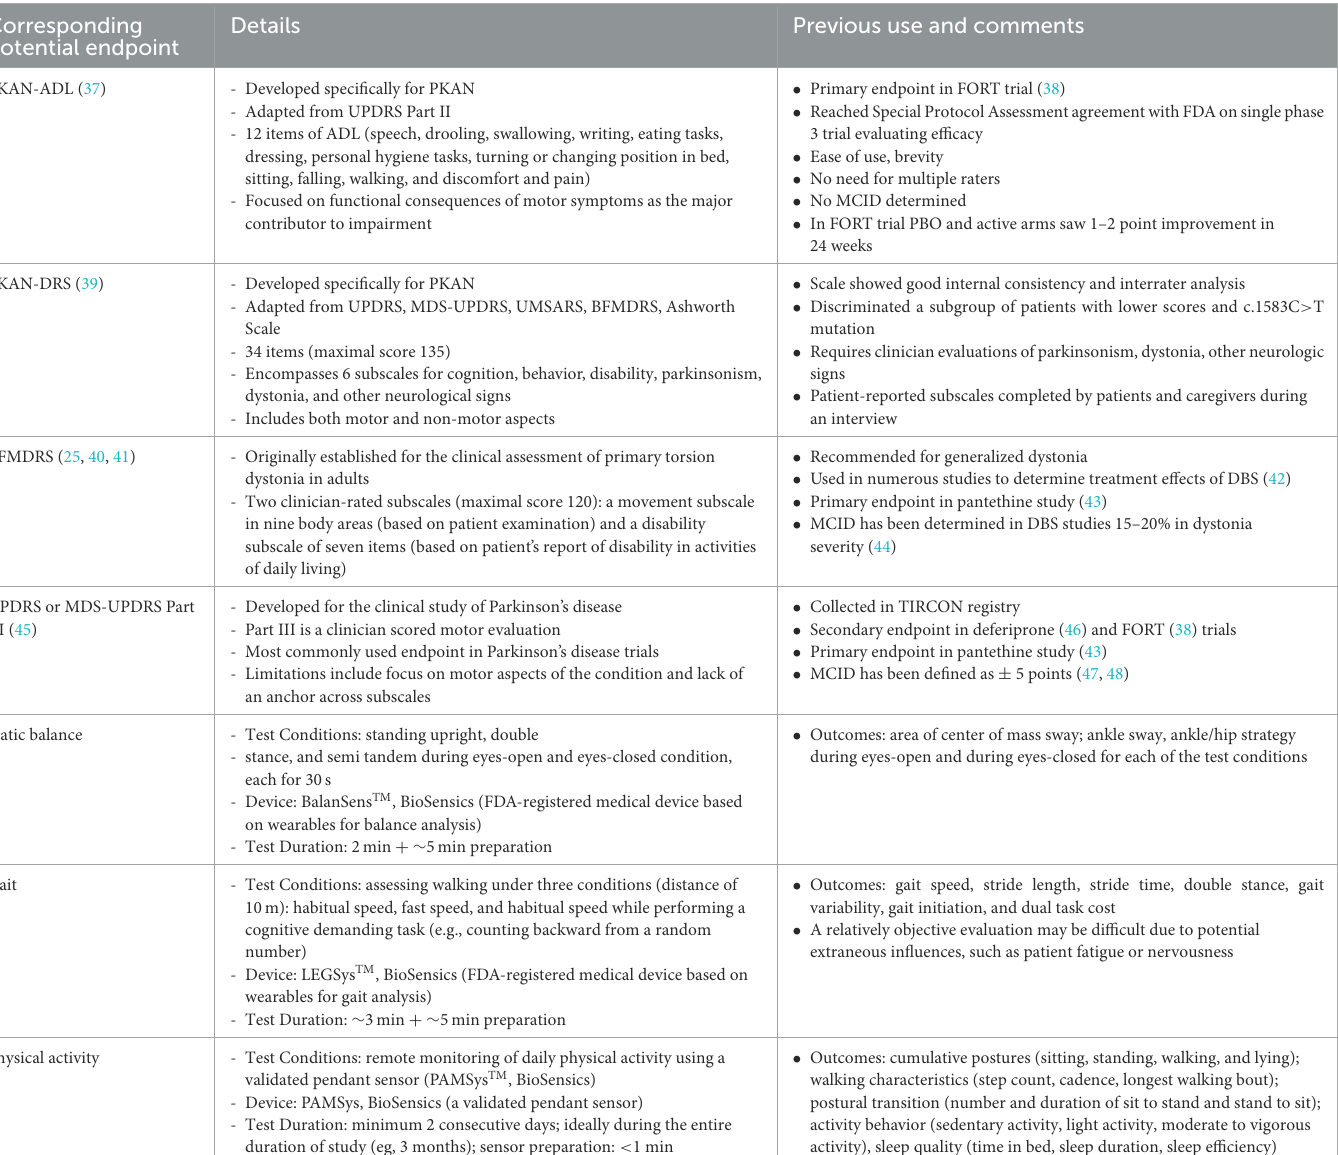
TABLE 2 Disease manifestations and corresponding potential endpoints in PKAN and other similar rare diseases presenting with